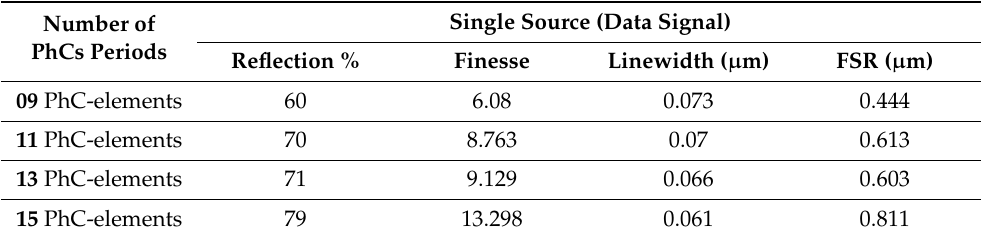
Table 2. Resonance characteristics of structures based on 9, 11, 13, and 15 PhC periods using data